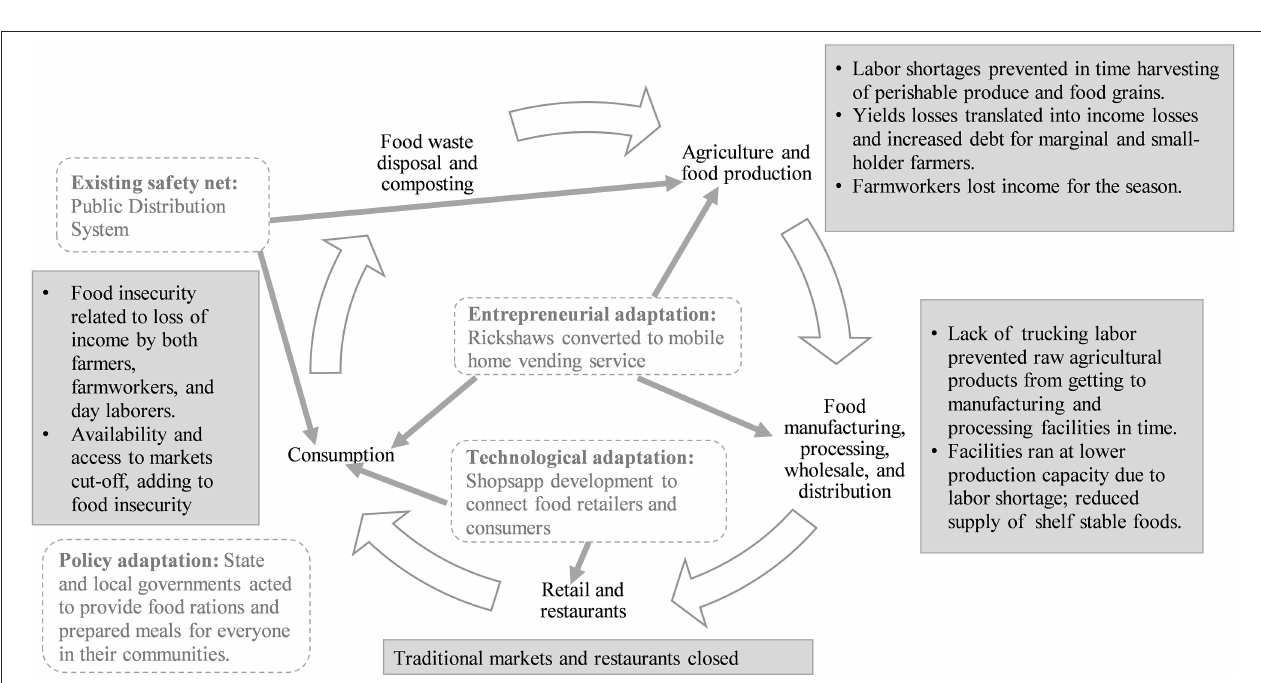
FIGURE 5 | COVID-19 impact on the food system and adaptations in Kerala,